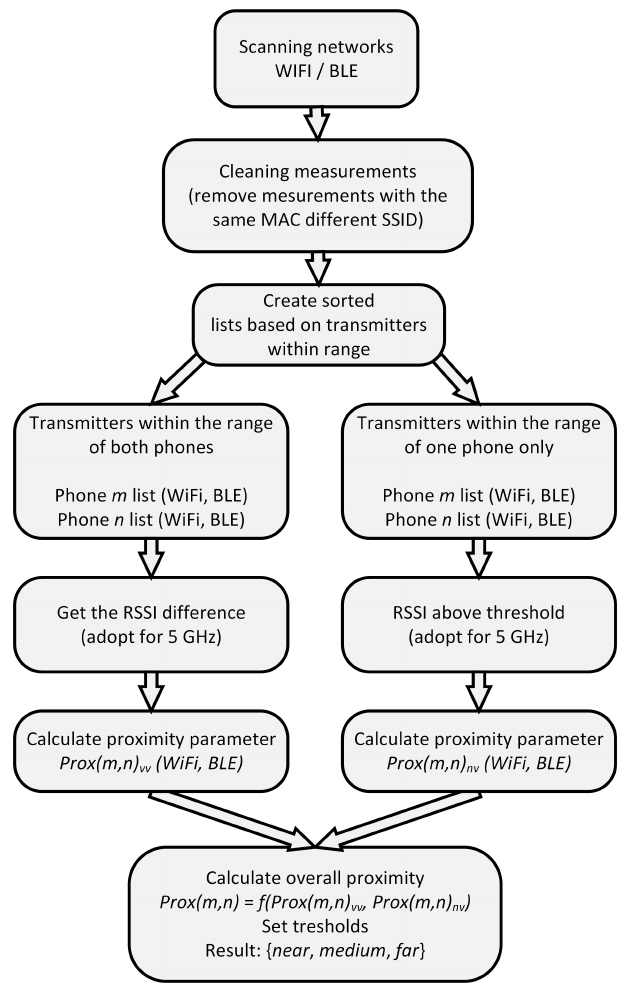
Figure 4. Proximity estimation procedure flow